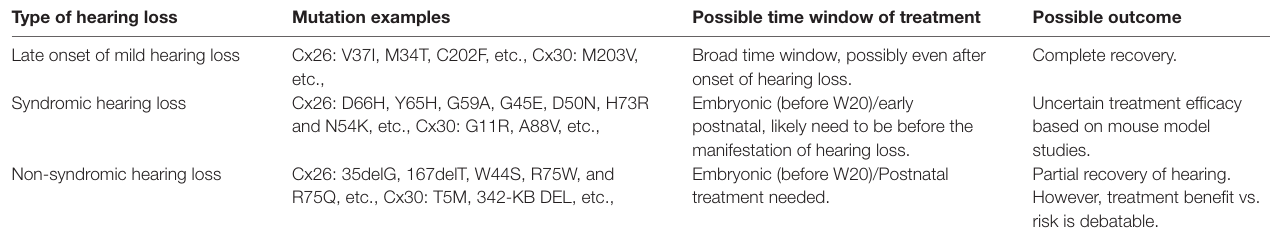
TABLE 1 | Types of Connexin26 (Cx26) and Cx30 human mutations and their possible treatment windows and outcomes by cochlear gene